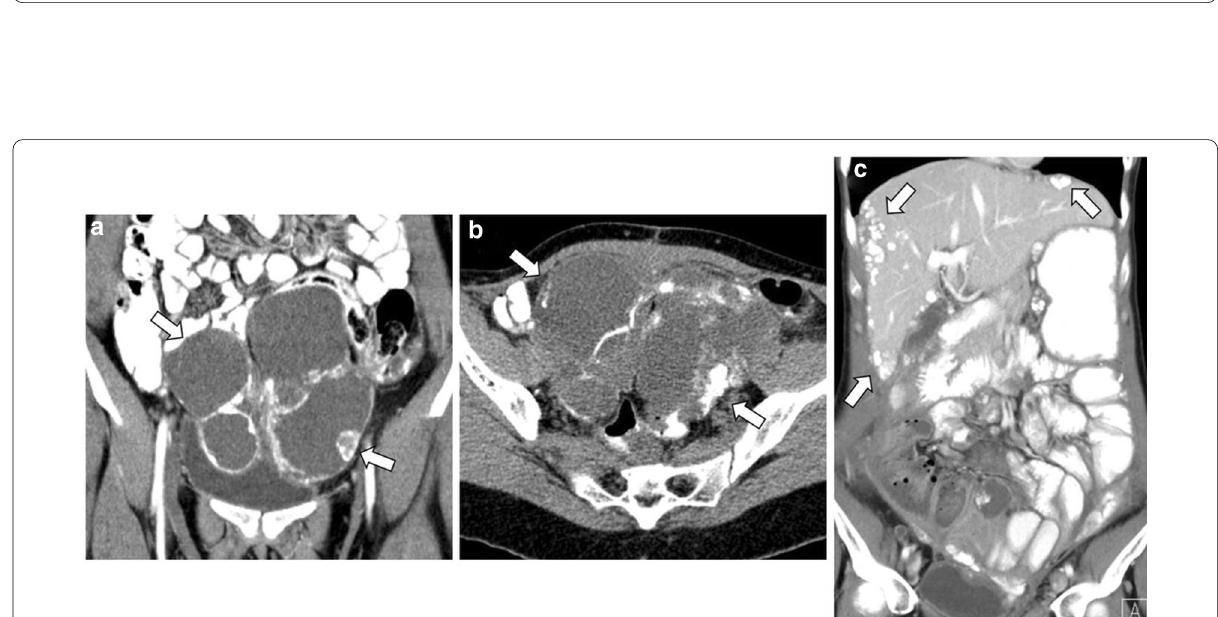
Fig. 5 Bilateral LGSC in a 28-year-old female. Coronal and axial enhanced CT images ( a , b ) display a bilateral multicystic tumour with thick septa and parietal nodules with multiple psammoma bodies (arrows). Enhanced CT image ( c ), 3 years after cytoreductive surgery, reveals peritoneal metastases on the hepatic surface and in subhepatic space with exuberant calcified psammoma bodies